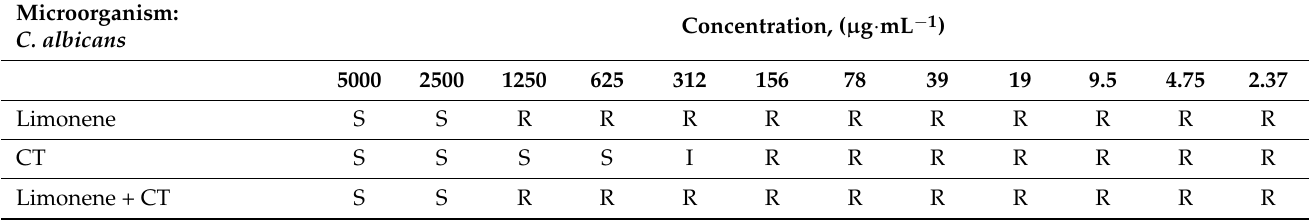
Table 7. Susceptibility of C. albicans at different